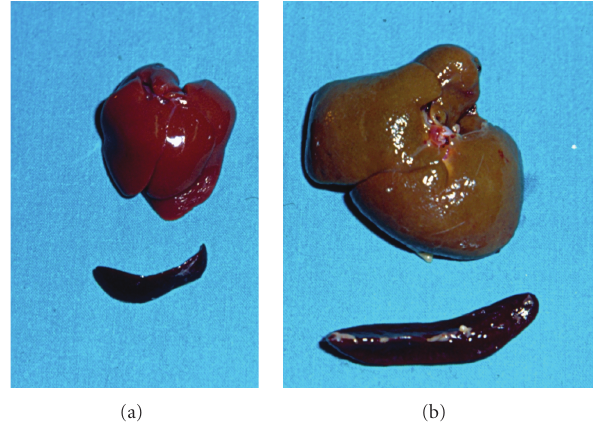
Figure 4: Liver and spleen in a sham-operated rat (a) and in a microsurgical extrahepatic cholestatic rat